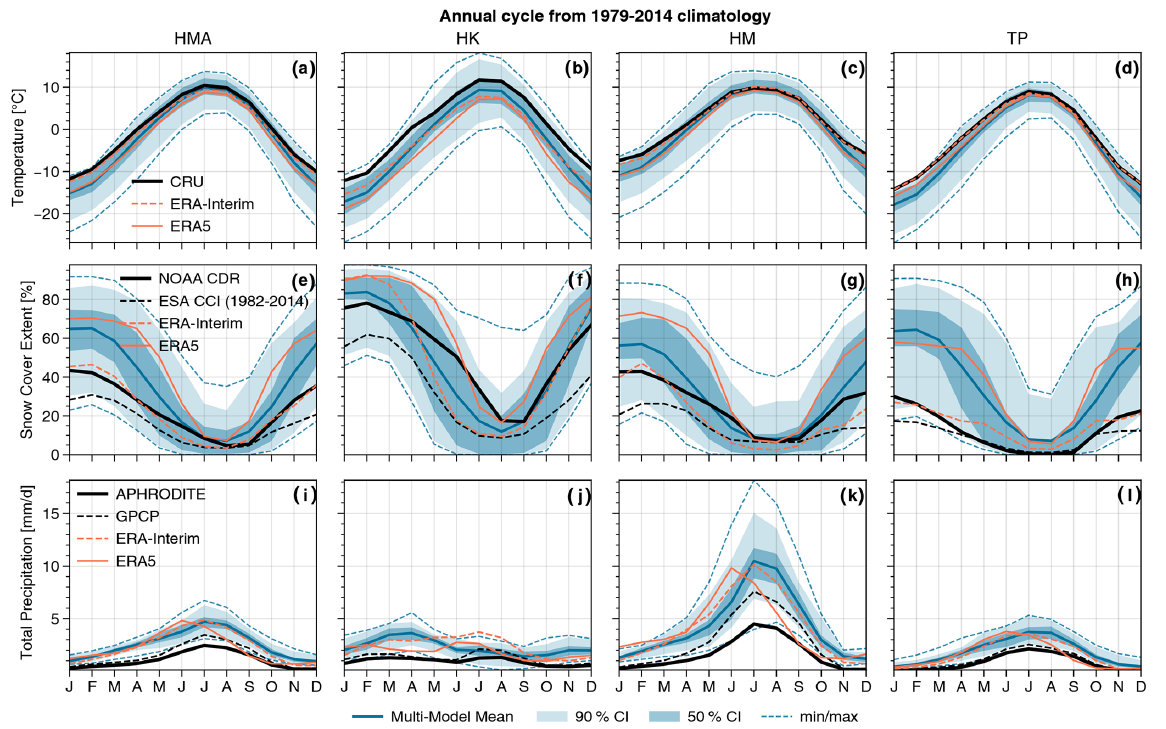
Figure 2. 1979–2014 climatology of the annual cycle of temperature (a–d) , snow cover (e–h) and precipitation (i–l) averaged over HMA (a, e, i) HK (b, f, j) HM (c, g, k) and TP (d, h, l) , excluding the surface area located below 2500ma.s.l. (red contours in Fig. 1). The multimodel mean (dark blue line) is shown with the 50% confidence interval (CI, dark blue shading), the 90% CI (light blue shading) and the minimum and maximum (dashed blue lines) of the ensemble. The black curves correspond to the observational datasets: CRU, NOAA CDR and APHRODITE, respectively, for temperature, snow cover and precipitation. The ERA-Interim and ERA5 reanalyses are shown, respectively, with the dashed and solid orange curves. GPCP and ESA CCI datasets are also shown for snow cover and precipitation respectively (dashed black line). The ESA CCI covers only the 1982–2014